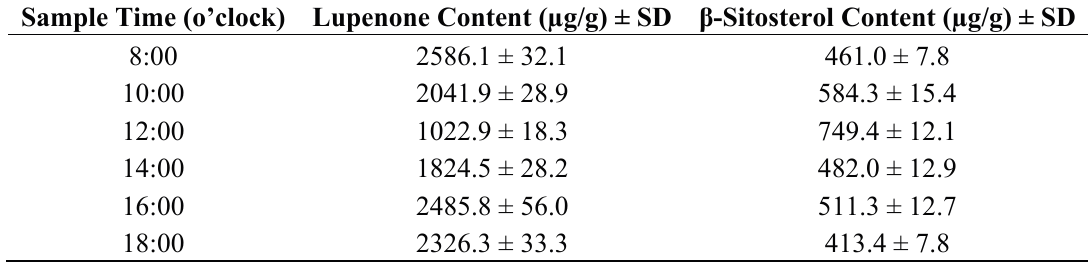
Table 6. Lupenone and β -sitosterol levels in Rhizoma Musae samples collected at different time periods within a single day.